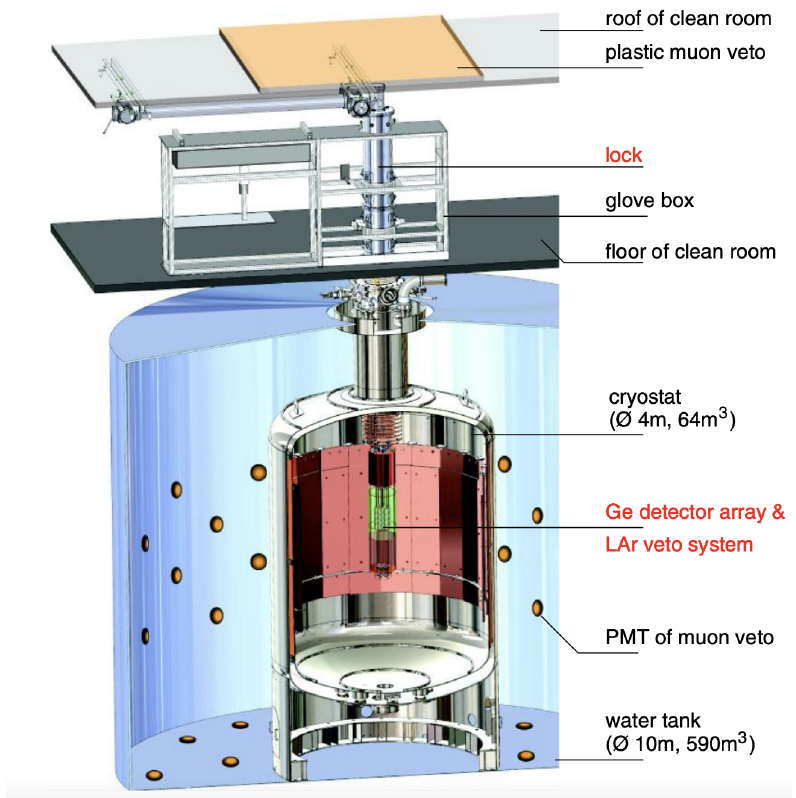
Figure 4. The illustration [30] of the G ERDA setup: the parts labeled in red were installed in 2015 and then deeply modified in 2018.